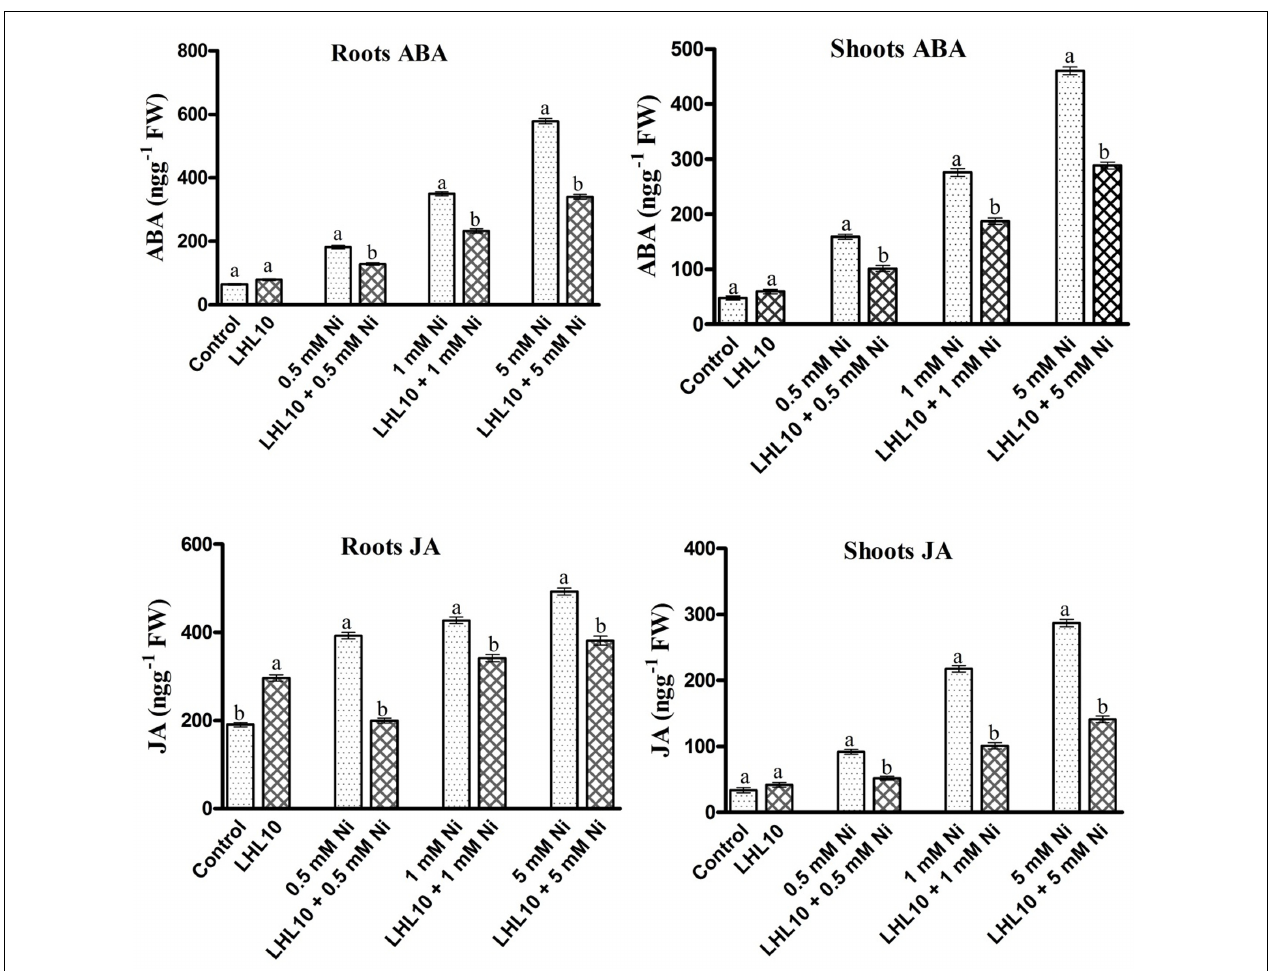
FIGURE 5 | Regulation of endogenous abscisic acid (ABA) and jasmonic acid (JA) in inoculated and non-inoculated soybean roots and shoots under different levels of Ni stress. Each value represents the mean ± standard error. Different letters on the bars represent significant differences between treatments (Tukey’s HSD, p <